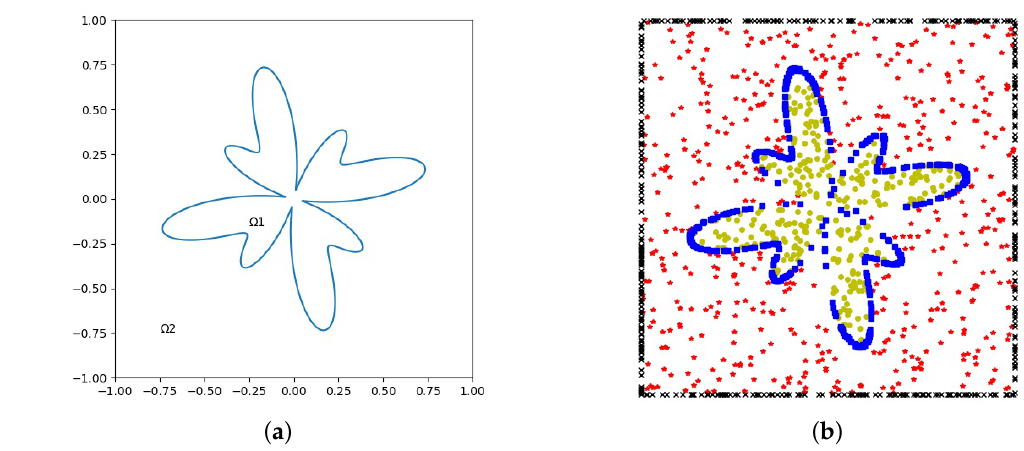
Figure 2. ( a ) Computational domain and interface geometry and ( b ) training points.